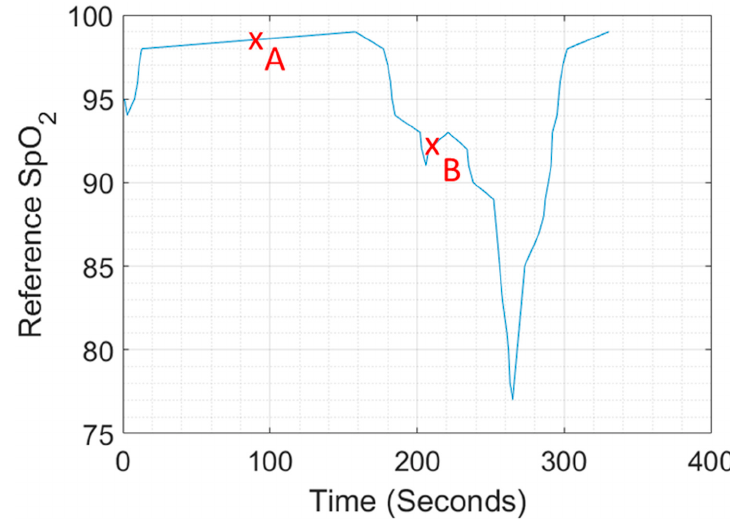
Figure 14. Reference SpO 2 variation over 330 s while holding a breath for 2 min (from point A to point B).